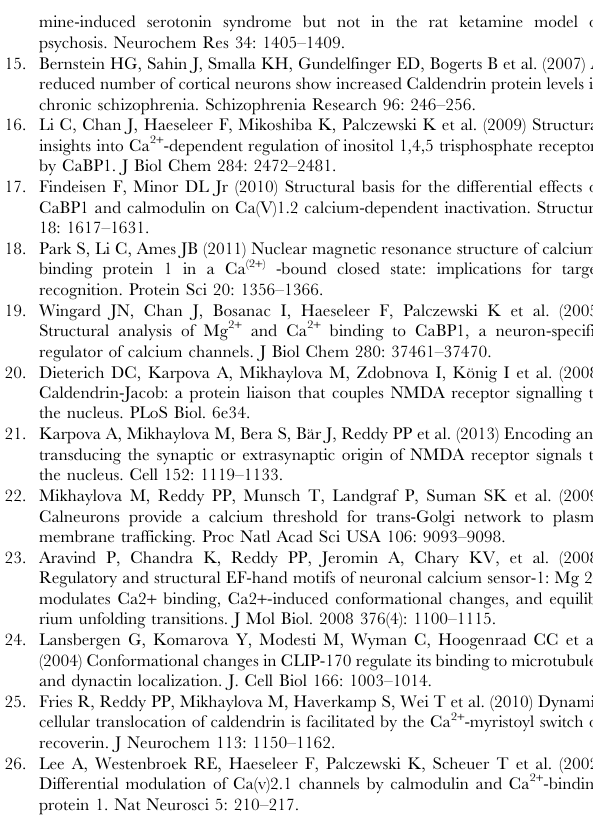
Figure S1 Scheme of Caldendrin/CaBP1 protein orga- nization, production and purification. (A) Purification of Caldendrin, L- and S-CaBP1 by the Impact Intein purification system. Coomassie staining shows Caldendrin full-length at different steps of purification starting from soluble protein in the supernatant (SN), flow through (FT), matrix bound (MB), eluted to dialyzed and concentrated protein. Myristoylated protein purifi- cation by the Impact purification system (right panel). Molecular masses are indicated. Figure S2 Caldendrin adopts a back-folded conforma- tion: in vitro FRET analysis. (A) Fluorescence spectra showing increased FRET efficiency in the positive control (CFP- YFP) and no FRET is observed in the negative control (CFP + YFP), where CFP and YFP were expressed by different vectors. (B) A clear FRET signal was detected in the YFP channel when YFP was fused to the N- and CFP to the C-terminus of Caldendrin (YFP-CDD-CFP). (C) Co-transfection of Caldendrin fused with YFP- to the N-terminus and Caldendrin fused with CFP to the C- terminus resulted in no FRET signal in the YFP-channel. (TIF)